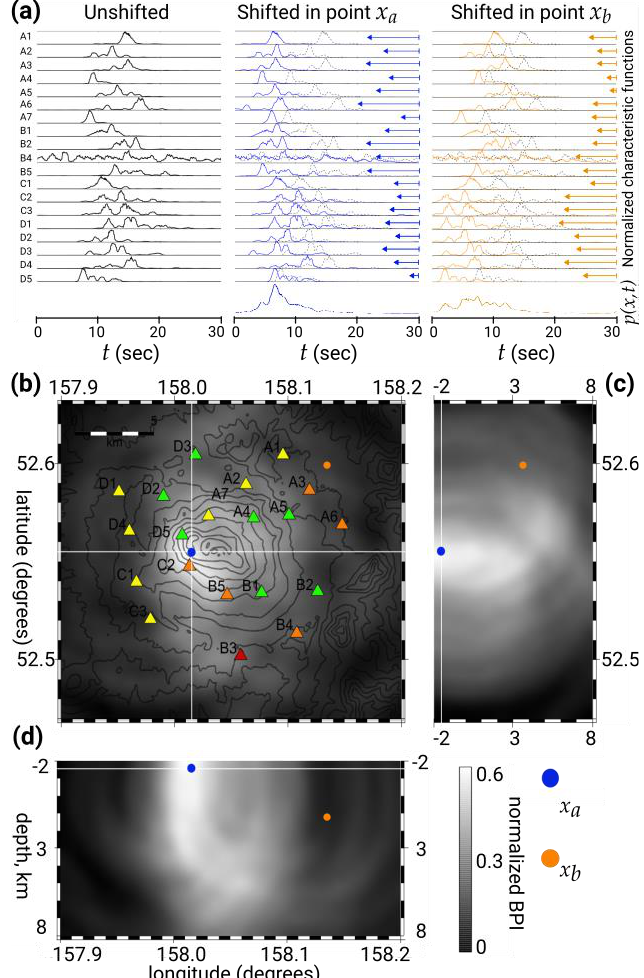
Figure 4. Example of the BP detection procedure for a high-energy LP event on Gorely: ( a ) signal envelopes (CFs) shifted according to precomputed travel-times; ( b ) horizontal, and ( c , d ) two vertical slices of 3-D BPI snapshot for a time of local maximum in detector function.